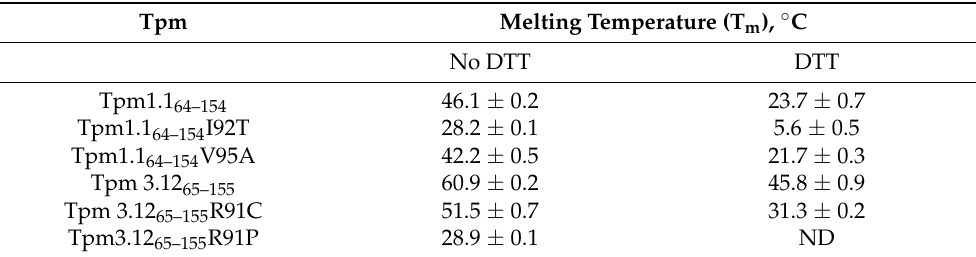
Table 1. Effect of the mutations on melting temperature (T m ) of Tpm1.1 64–154 and Tpm3.12 65–155 under non-reducing and reducing conditions. Melting temperatures were determined from melting curves measured in 10 mM Na-phosphate, 100 mM NaCl, pH 7.0, under reducing (0.5 mM DTT) and non- reducing (no DTT) conditions. ND: not determined. The numbers are mean values from three meas- urements ± SE.